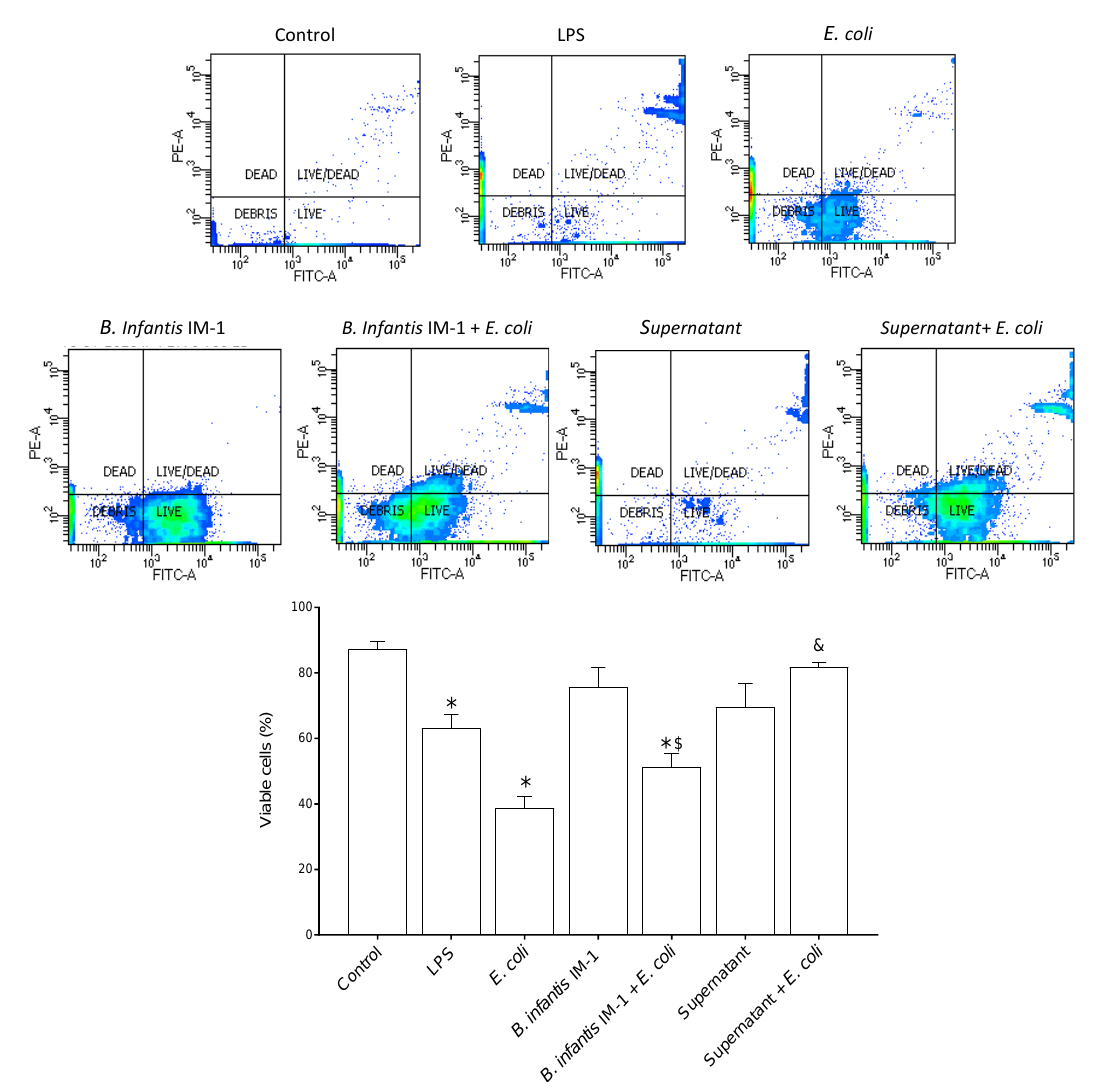
Figure 1. Flow cytometry analysis of Caco-2 cell viability. Viability of Caco-2 cells treated for 8 h with either LPS, E. coli (1:100 Caco-2: E. coli ), B. infantis IM-1 ® (1:30 Caco-2: B. infantis IM-1 ® ) or B. infantis IM-1 ® supernatant in the presence or absence of E. coli . Results are expressed in percentages as the mean ± SEM of three independent experiments. * p < 0.05 vs. control (untreated cells); $ p < 0.05 vs. B. infantis IM-1 ® ; & p < 0.01 vs. B. infantis IM-1 ® + E. coli .